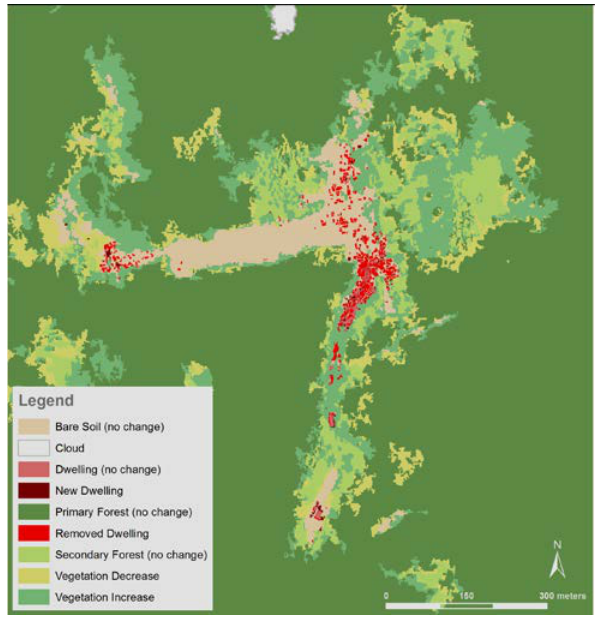
Fig. 4. Results of the land cover classifications from September 2010 until March 2011.